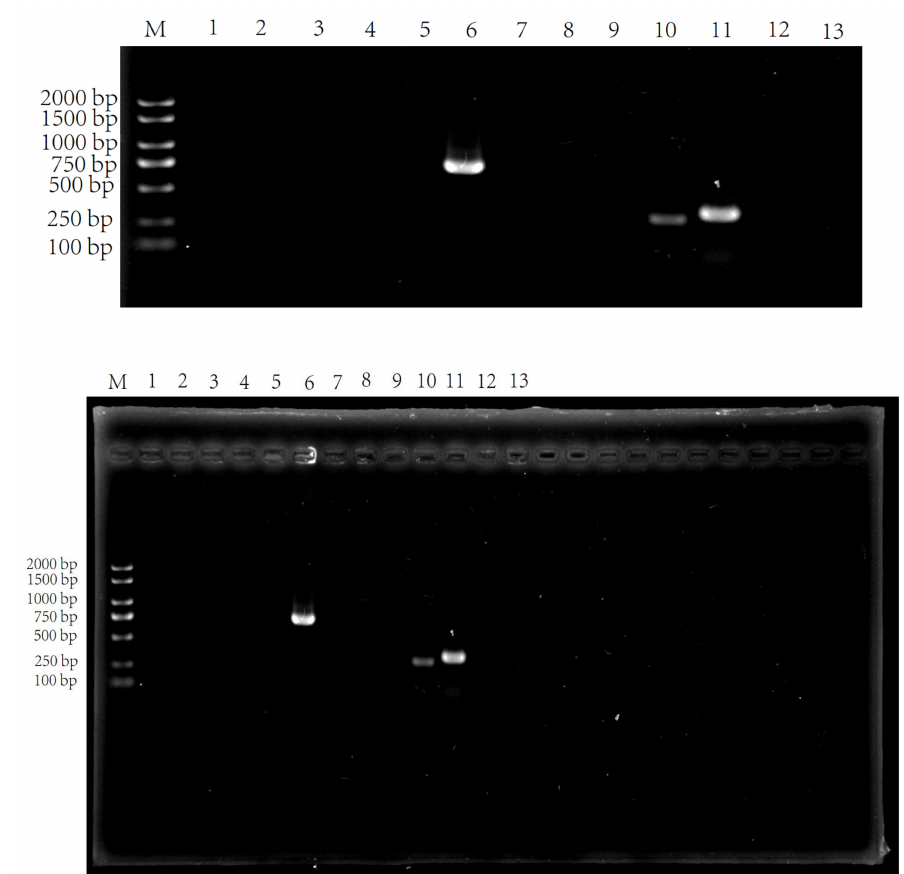
Figure 7. Agarose gel (1.5%) electrophoresis of the PCR products of bacteriocin-related genes. Lane numbers represent bacteriocin-related genes as follows: M. DL2000 plus DNA Marker; 1. pln423 ; 2. plnQ ; 3. plnN ; 4. PlnNC81F ; 5. plnXY ; 6. plnW ; 7. plnJK ; 8. plnA ; 9. plnEF ; 10. plnS ; 11. ped ; 12. pln ; 13. ent .